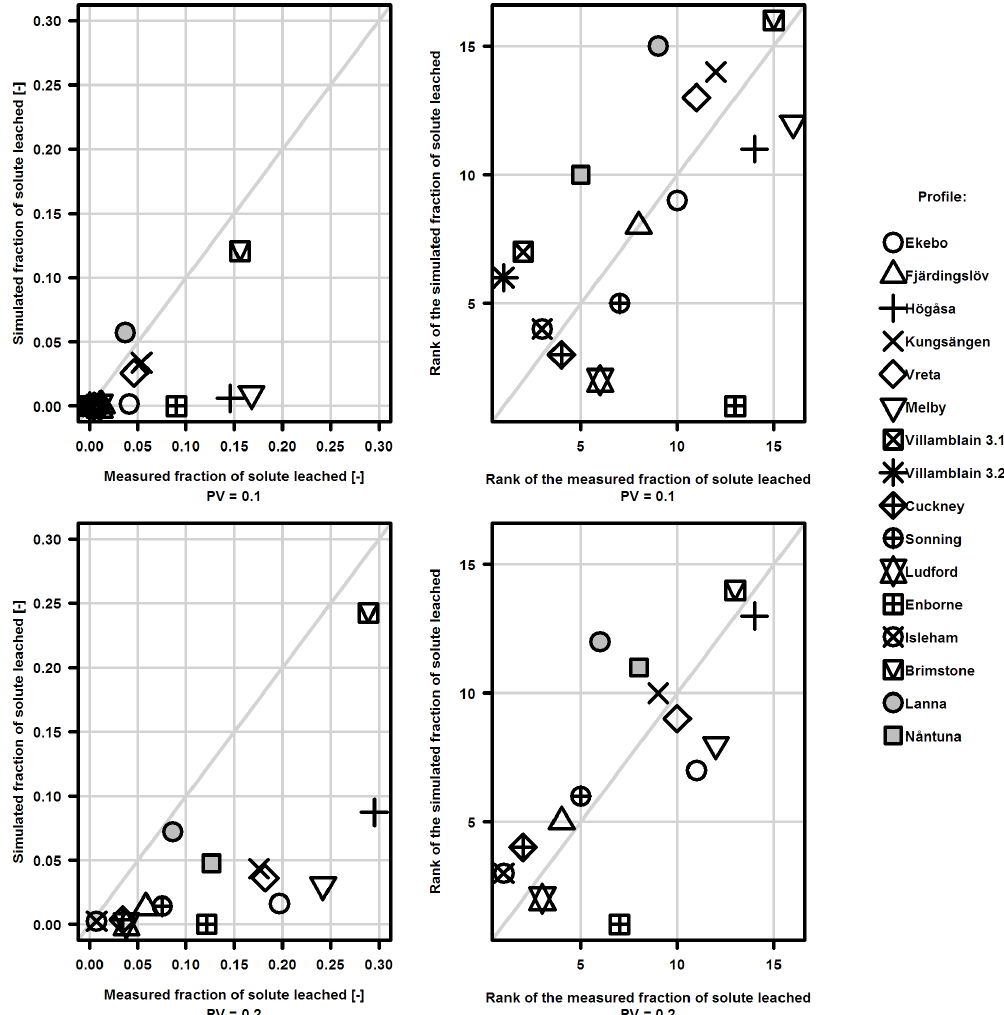
Fig. 4. Left part: measured versus simulated accumulated solute loads leached at 0.1 (upper part) and 0.2 (lower part) pore volumes (PV), expressed as a fraction of the applied solute [–]. Right part: soil ranks according to the same criterion. At 0.2 pore volume, Villamblain 1 and 2 soils are not represented, because neither the simulation nor the measurements reached that pore